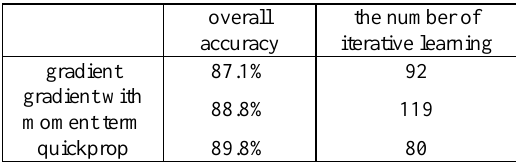
Table 1. Classification result and the number of learning at